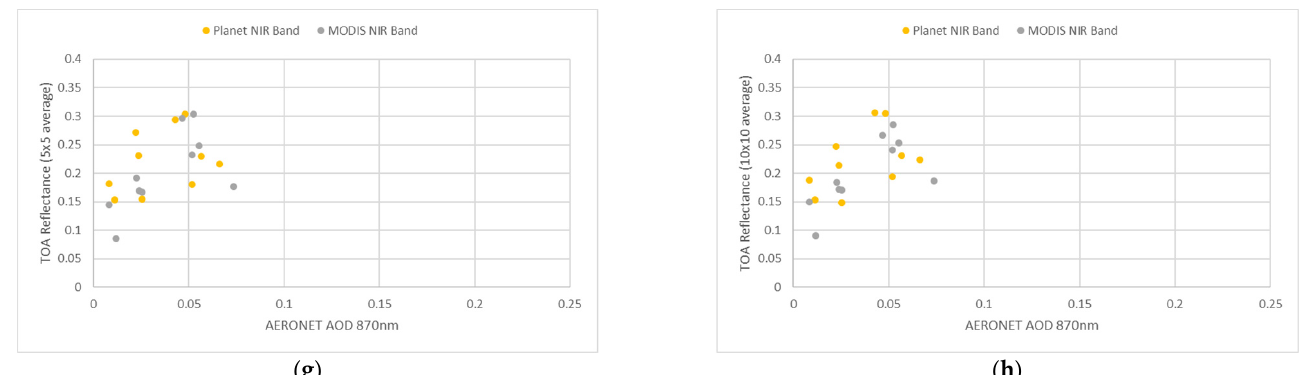
Figure 8. Three-hour averaged AOD on the x-axis plotted against ( a ) blue band TOA reflectance for a 5 × 5 pixel average; ( b ) blue band TOA reflectance for a 10 × 10 pixel average; ( c ) green band TOA reflectance for a 5 × 5 pixel average; ( d ) green band TOA reflectance for a 10 × 10 pixel average; ( e ) red band TOA reflectance for a 5 × 5 pixel average; ( f ) red band TOA reflectance for a 10 × 10 pixel average; ( g ) NIR band TOA reflectance for a 5 × 5 pixel average; ( h ) NIR band TOA reflectance for a 10 × 10 pixel average on the y-axis; for both PlanetScope and MODIS for all 10 data points. PlanetScope points are in color and MODIS points are grey.